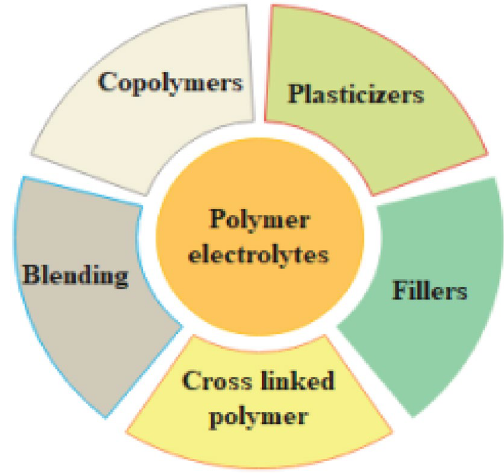
Fig. 5 Schematic representation of various strategies for achieving high performance PE. Modified from reference